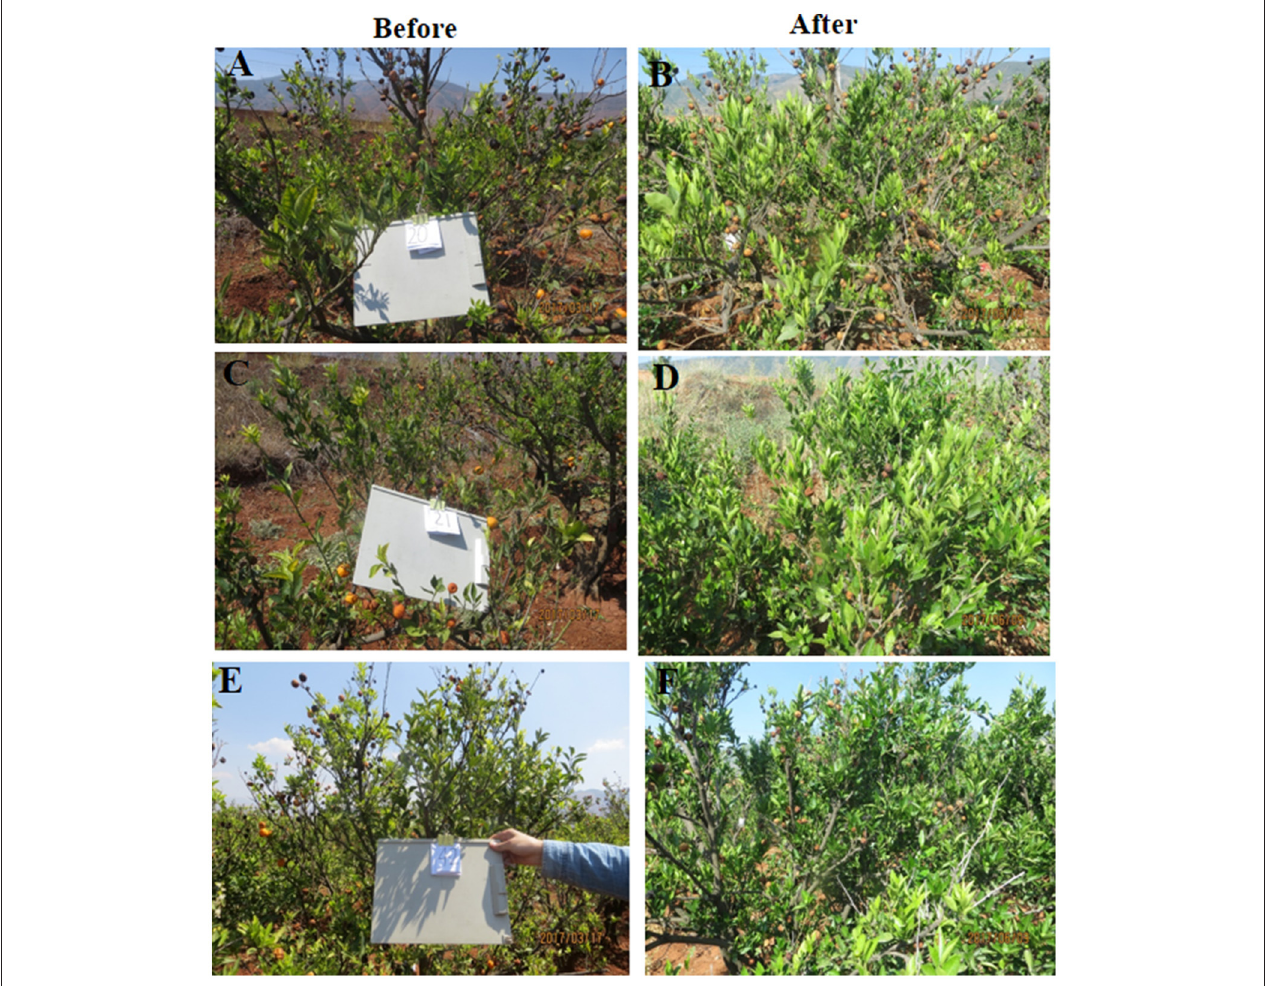
FIGURE 5 | Huanglongbing affected diseased citrus groves before and after application of endophyte L1-21 in Binchuan county, Yunnan Province, China. The citrus groves were checked for C Las pathogen detection before the start of the experiment to make sure that all the citrus trees are affected with HLB. (A,C,E) In March 2017, the citrus grove was affected with HLB and (B,D,F) In June 2017, trees displayed more robust growth with green leaves after Bacillus subtilis L1-21